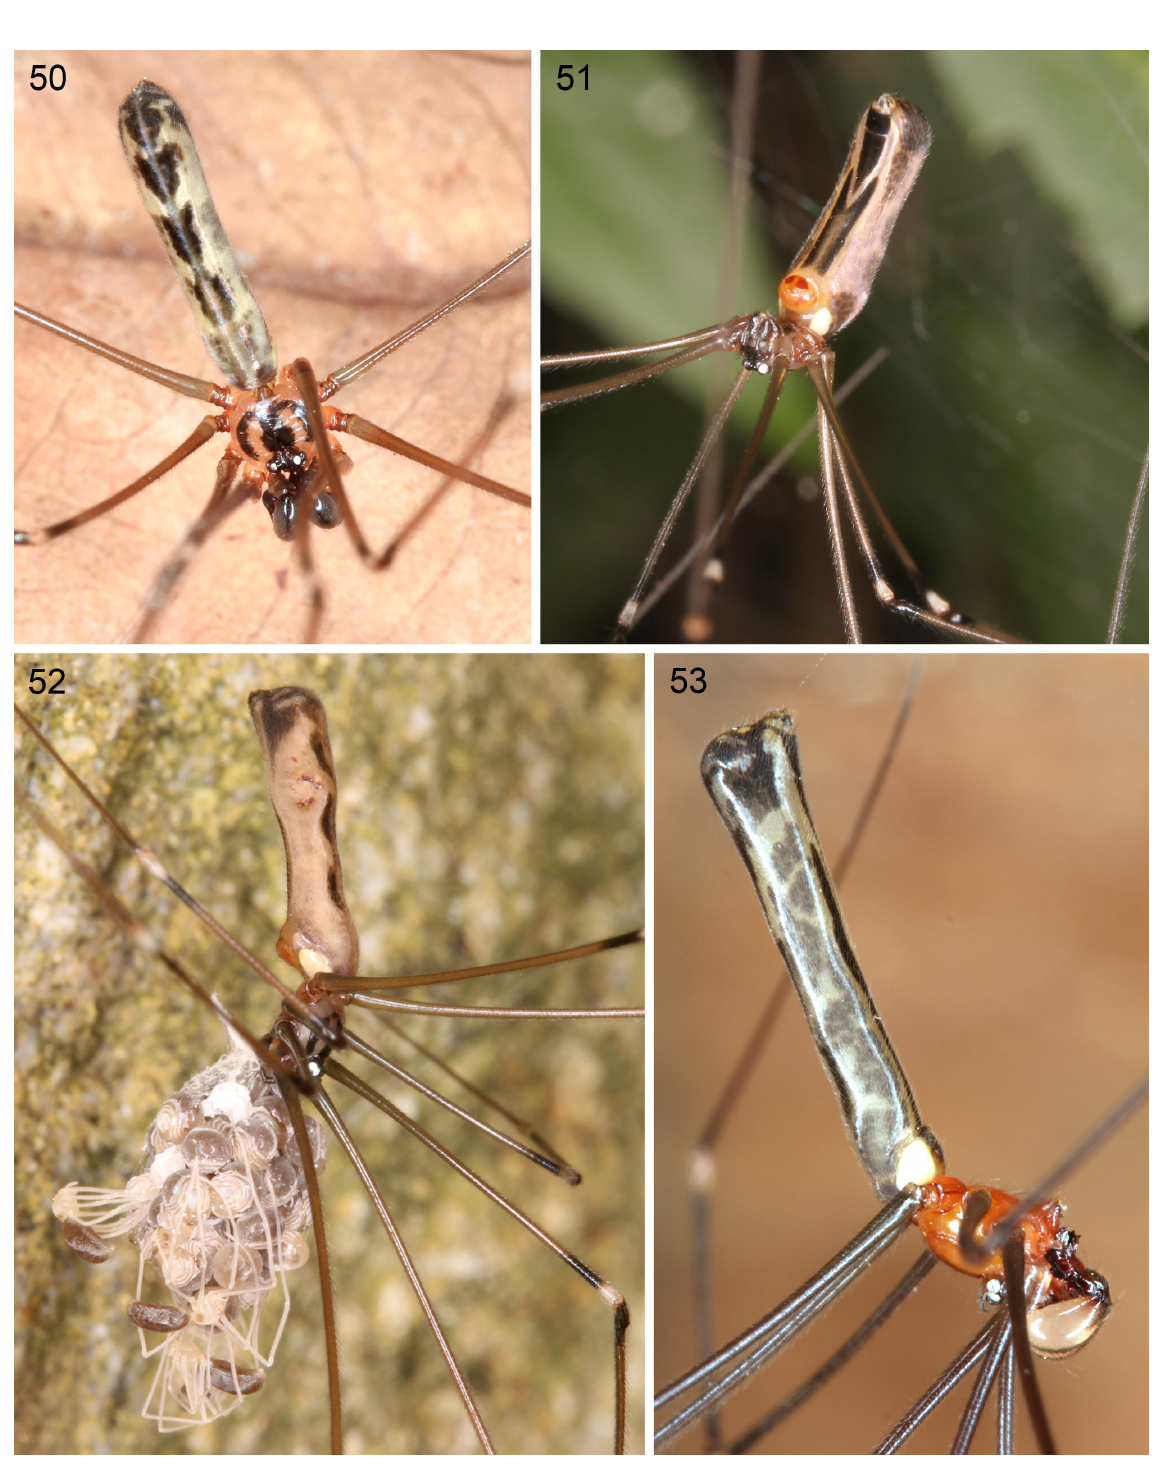
Figs 50–53. Live specimens. 50–52 . Pholcus baguio Huber, sp. nov., ♂, ♀, and ♀ with egg-sac